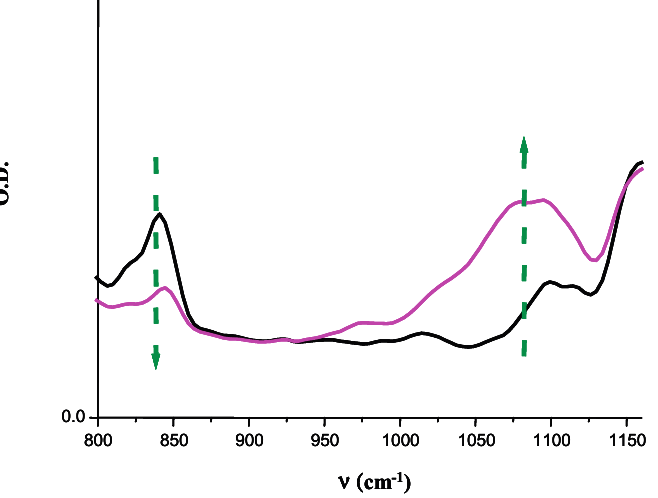
Figure 6. Tunable organophotocatalysts for polymerization reactions under visible lights: ( a ) reaction scheme for OPC and ( b ) polymerization profiles of EPOX under air upon: a red LED bulb irradiation in the presence of: (1) Pent /Ph 2 I + (0.5%/2% w / w ); and (2) Pent /(TMS) 3 Si-H/Ph 2 I + (0.5%/3%/2% w / w ) [111].